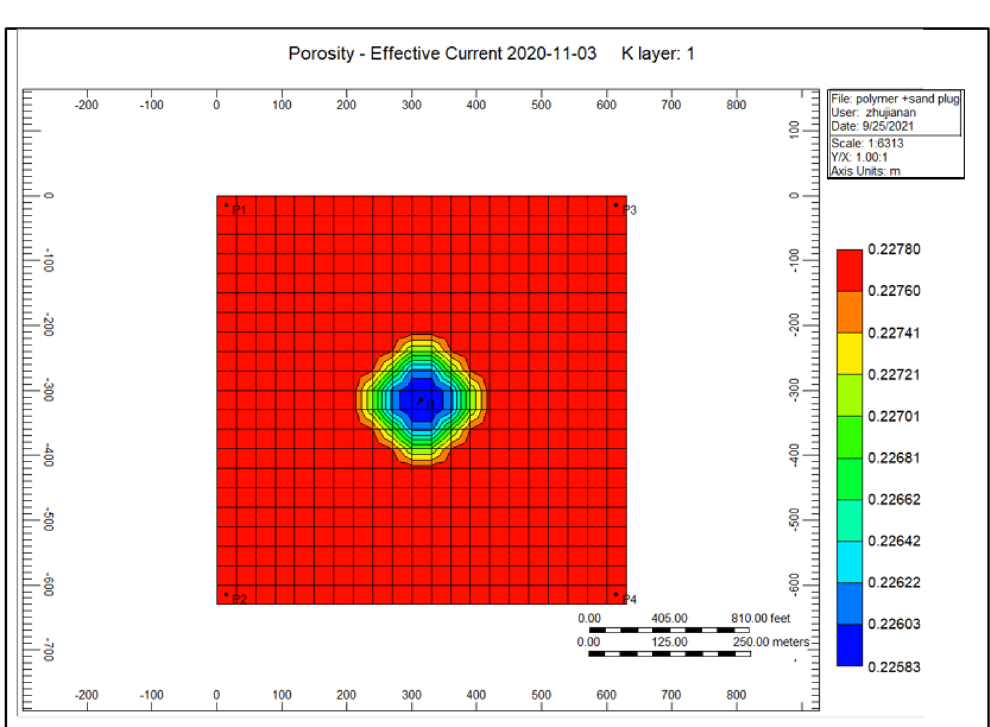
Figure 18. Shows the porosity diminish throughout the polymer sand plug model CMG STARS 2017.10 URL: https:// www. cmgl.